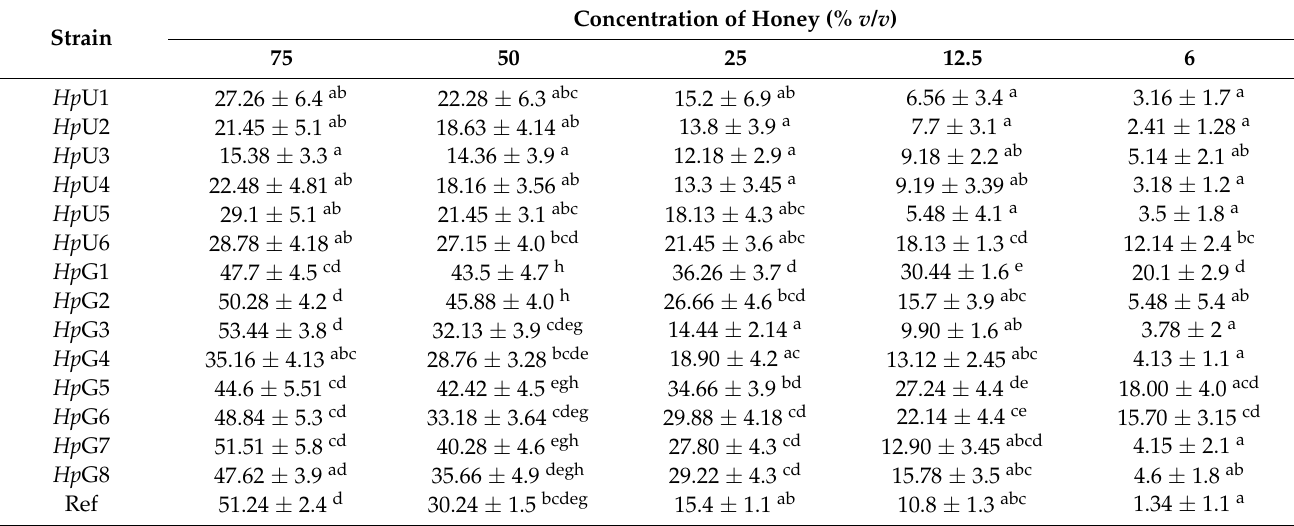
Hp U1 to Hp U6 are H. pylori strains isolated from ulcers, while Hp G1 to Hp G8 are H. pylori strains isolated from gastritis. Ref: H. pylori DSM21031 (reference strain). Similar superscript letters indicate no statistically significant differences (ANOVA with Tukey’s HSD post hoc multiple range tests) among the various H. pylori strains for the same concentration of